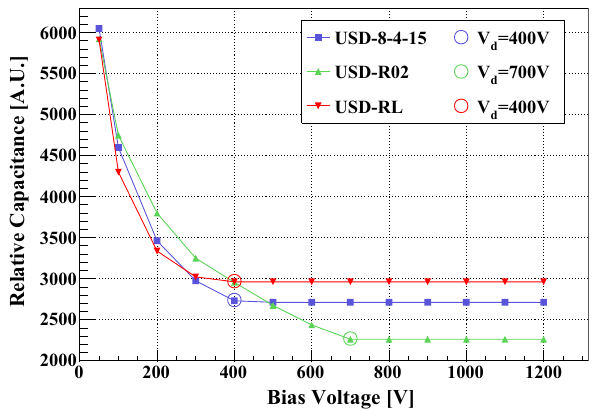
Fig. 4 Relative capacitance as a function of bias